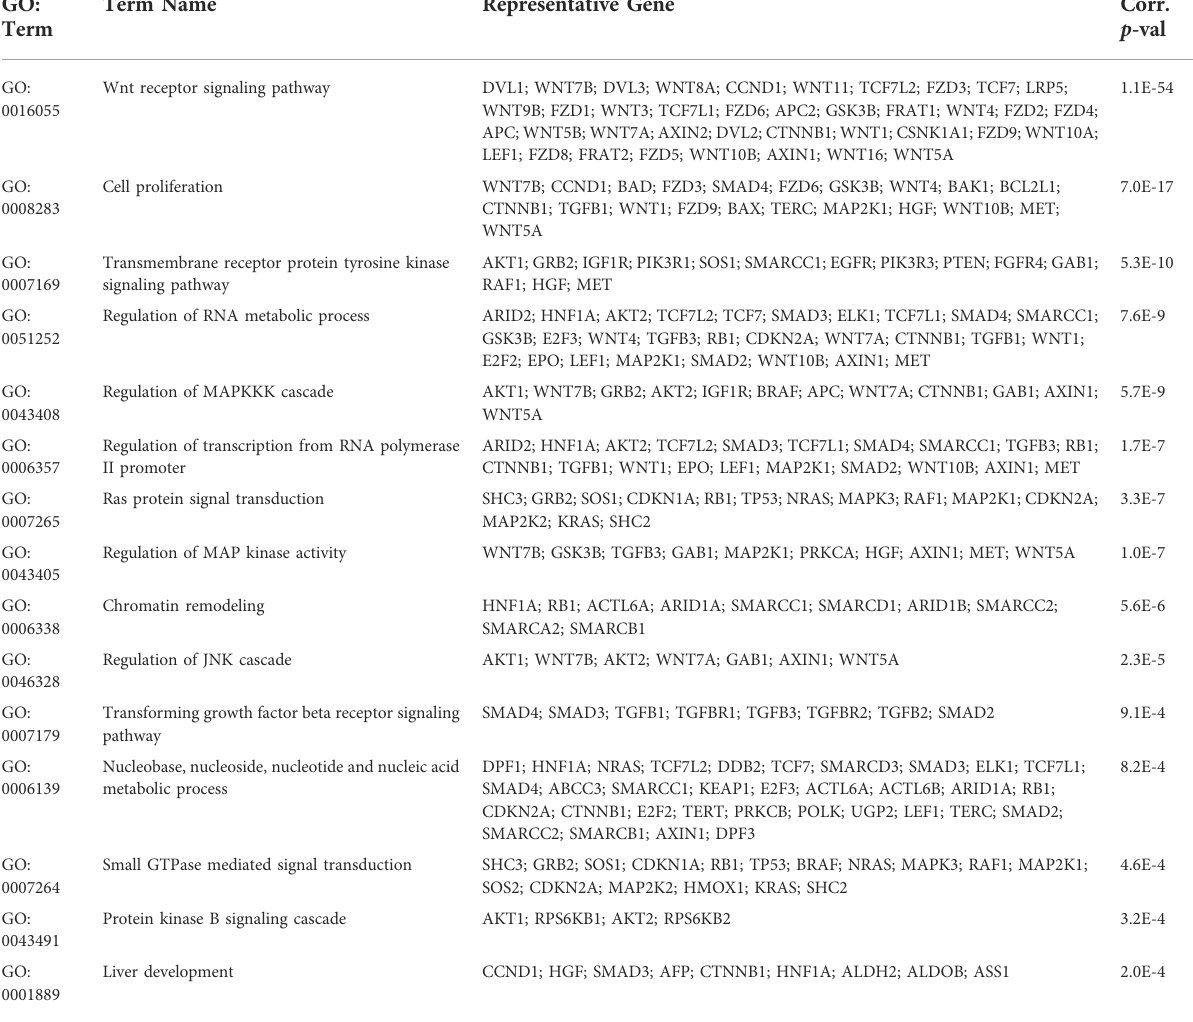
TABLE 4 The enrichment of GO biological process and KEGG pathway in HCC